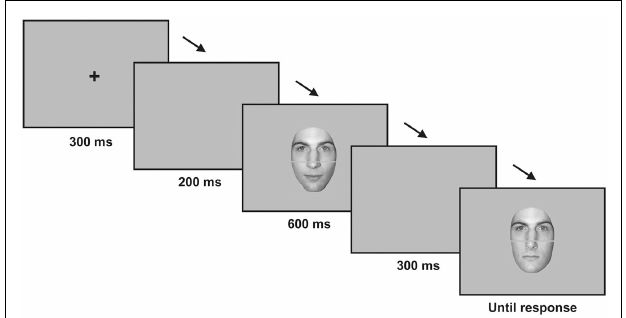
FIGURE 5 |Time course and stimuli used to test participants’ composite face effect. Participants focused the top parts (Experiment 2A) or the bottom parts (Experiment 2B) of two faces presented sequentially in order to decide whether they were the same or different.